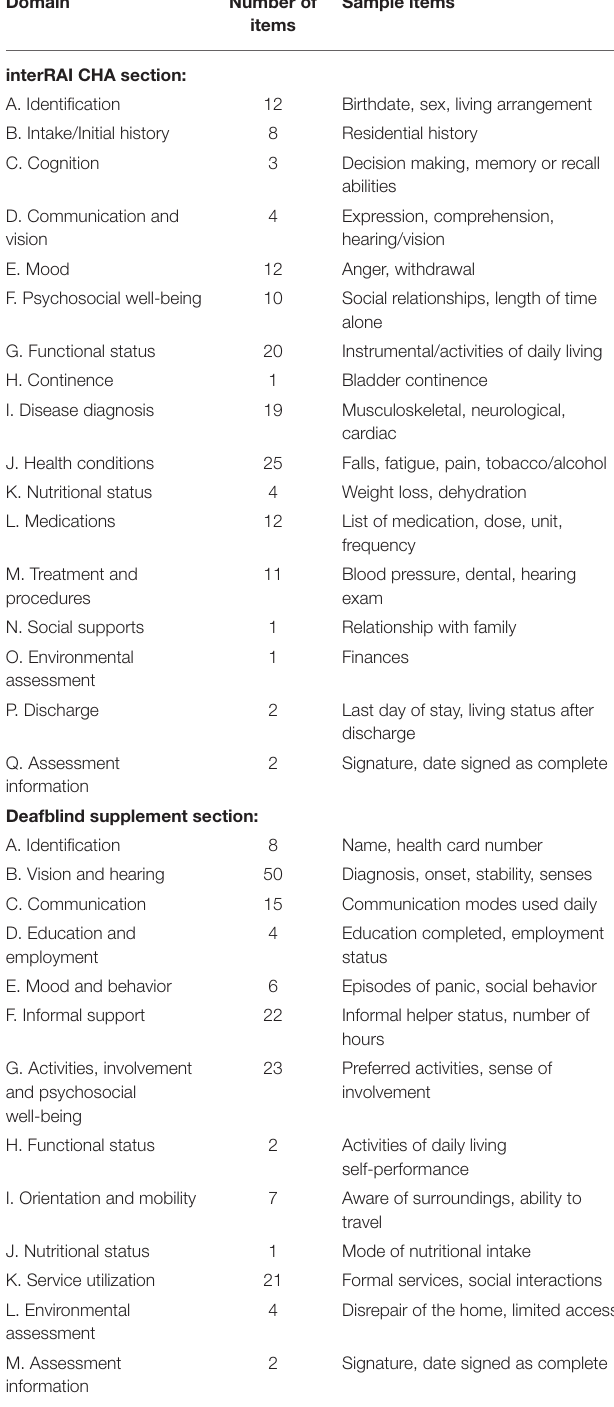
TABLE 1 | Key domains of the interRAI Community Health Assessment (CHA) and deafblind